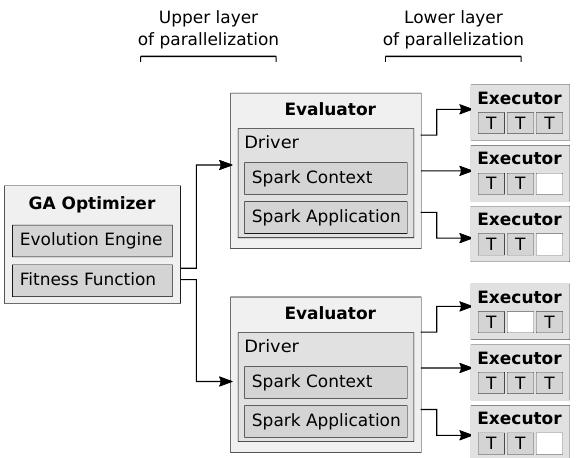
Figure 7. Dual levels of parallelization are shown where the GA optimizer distributes the flight path candidates to different evaluators for fitness score computation. To evaluate a flight path candidate, each evaluator partitions and distributes the work to multiple executors, each of which can use multiple parallel